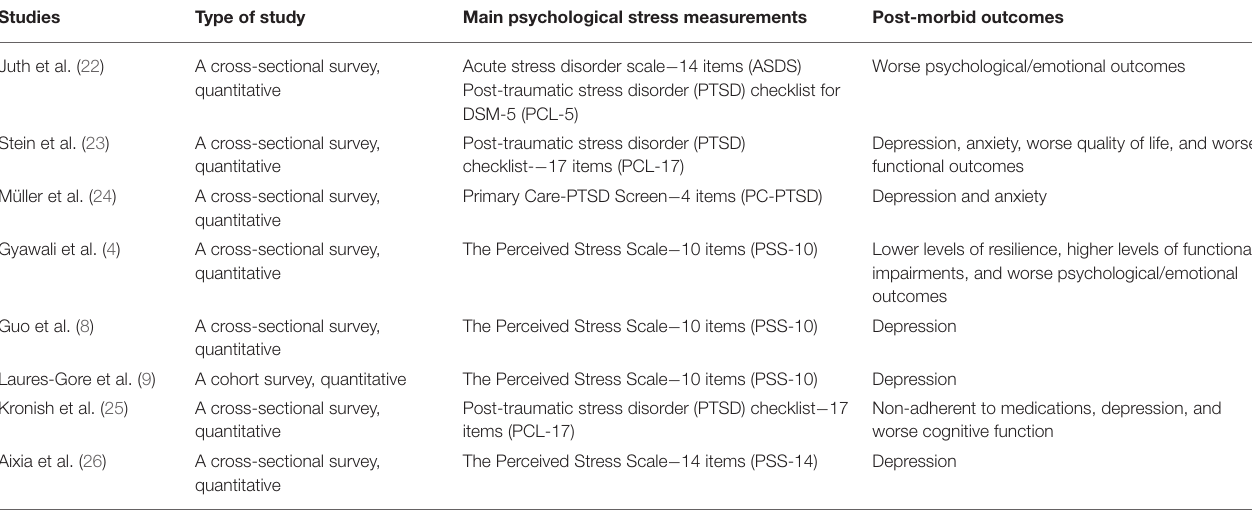
TABLE 2 | Different types and measurement methods of psychological stress after stroke and its effects on the postmorbid